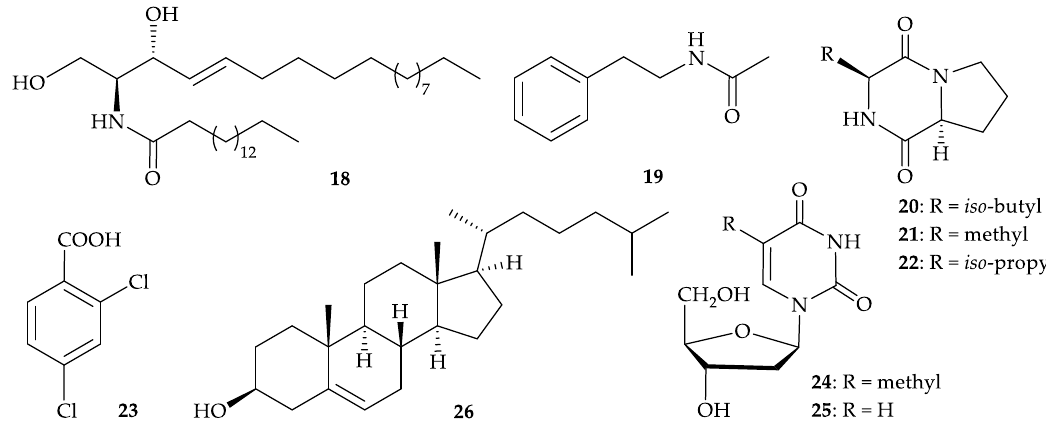
Figure 5. Structures of (2 S ,3 R ,4 E )- N -hexadecanoyl-2-amino-4-octadecane-1,3-diol ( 18 ), N -phenethyl -acetamide ( 19 ), cyclo-(Leu-Pro) ( 20 ), cyclo-(Ala-Pro) ( 21 ), cyclo-(Val-Pro) ( 22 ), 2,4-dichlorobenzonic acid ( 23 ), thymidine ( 24 ), 2 ′ -deoxyuride ( 25 ), and cholesterol ( 26 ).